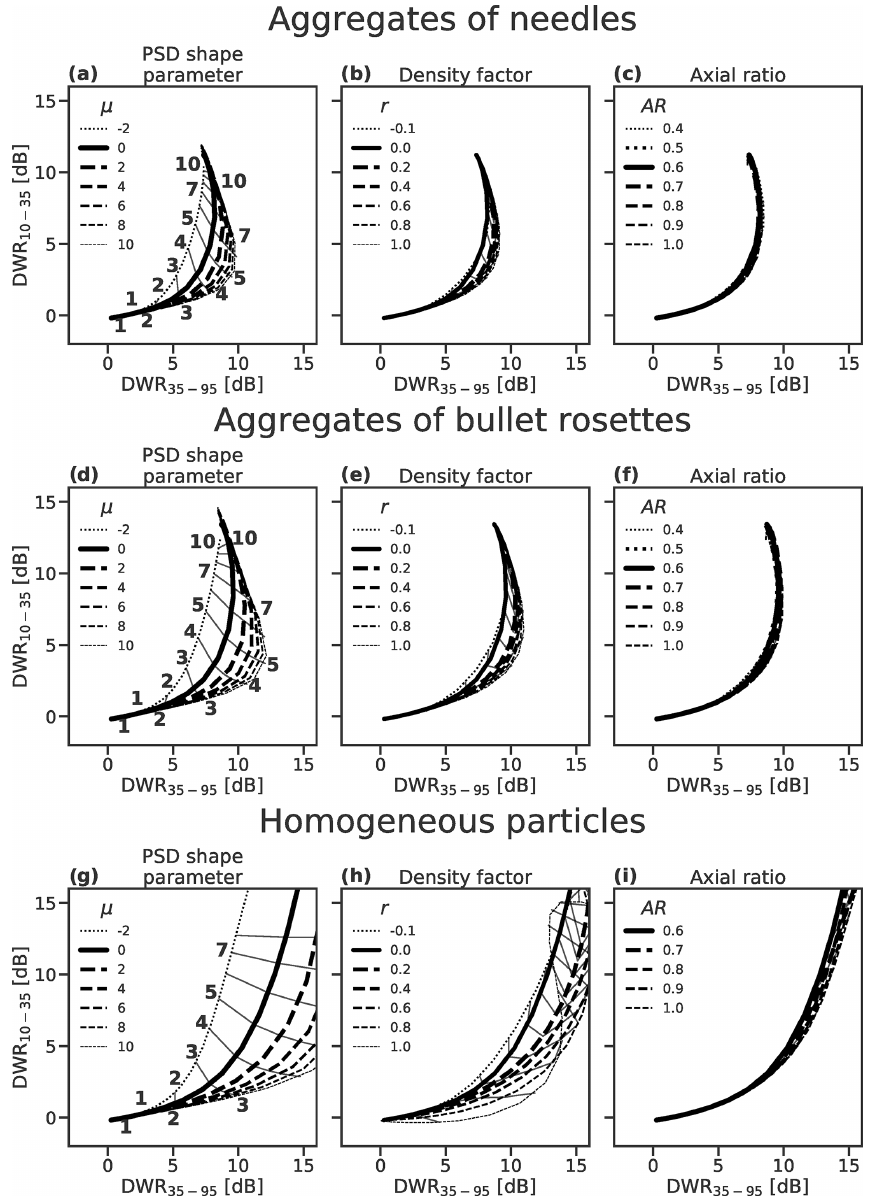
Figure 3. Simulated triple-frequency radar signatures for distributions of aggregates of needles (a–c) and aggregates of bullet rosettes (d–f) , represented using SSRGA, and homogeneous spheroids (g–i) . Black lines illustrate radar signatures for a spectrum of PSDs with median volume diameters (values indicated in panels a and d ) for different values of (a, d, g) PSD shape parameter, (b, e, h) density factor and (c, f, i) axial ratio. Lateral lines denote increments of median volume diameter in